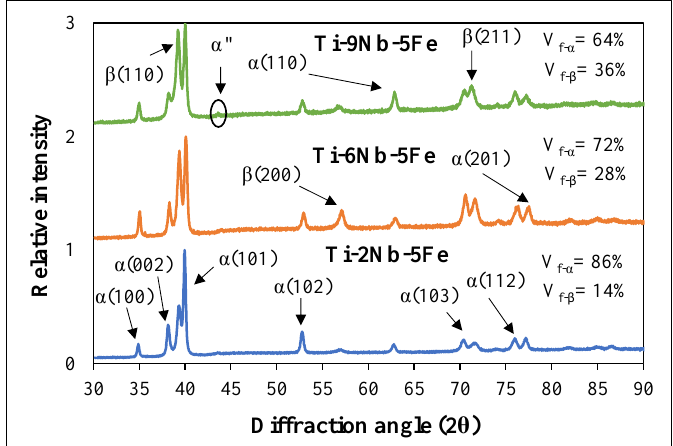
Figure 3. XRD spectra of the Ti-5Fe-xNb alloys.